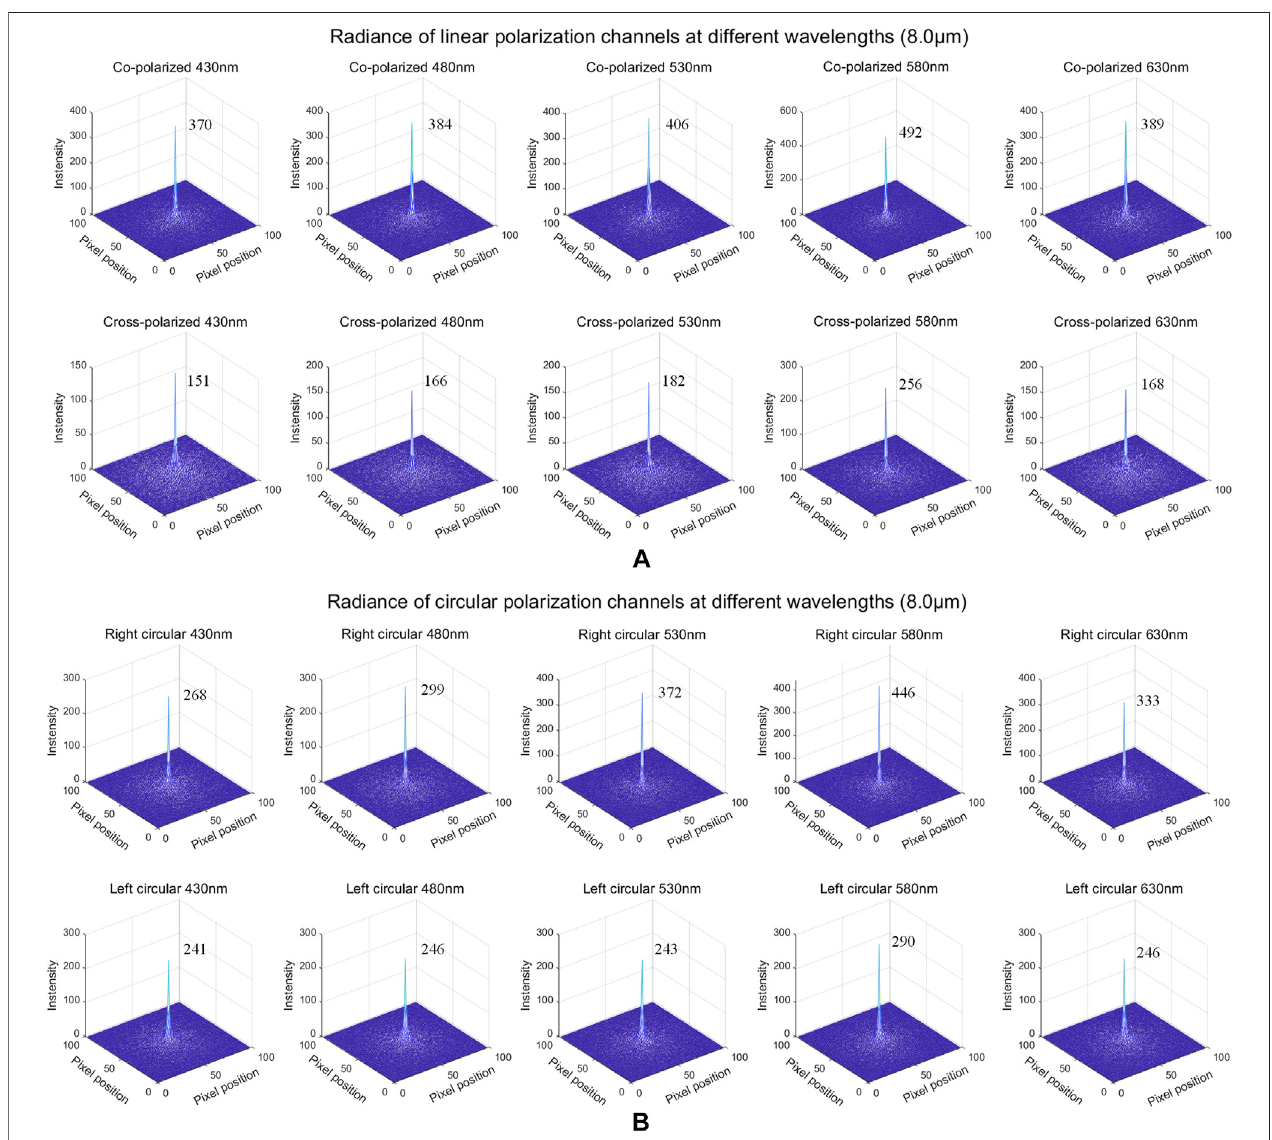
FIGURE 5 | Radiance of polarization channels at different wavelengths in the medium with large-sized particles (8.0 μ m). (A) co-polarized and cross-polarized radiance, (B) right circular and left circular polarized radiance.